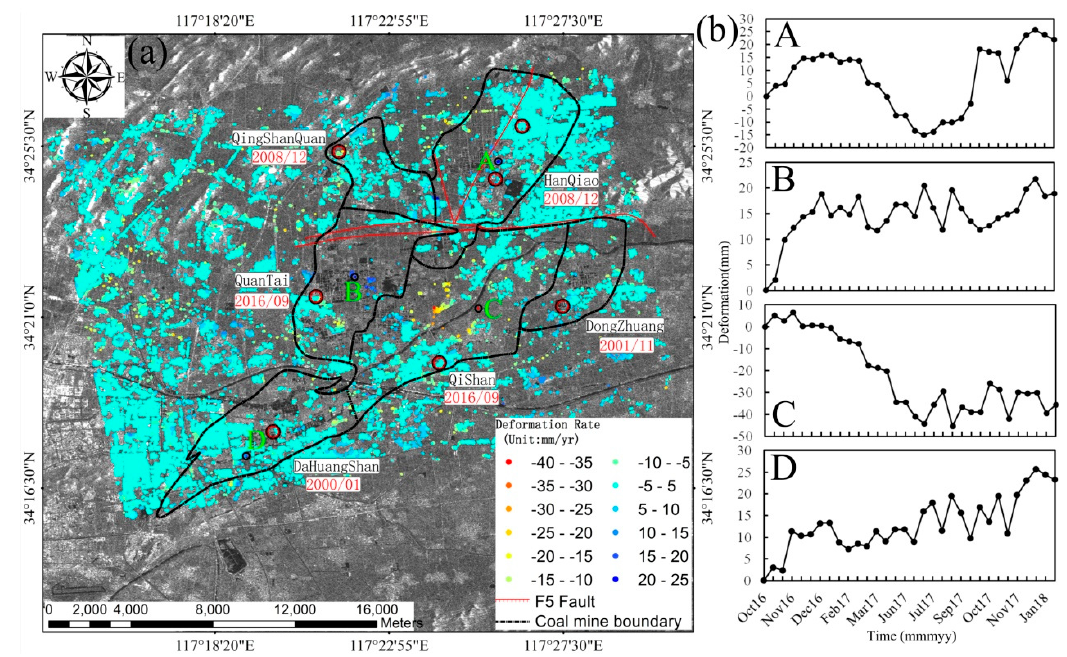
Figure 5. The LOS deformation from October 2016 to January 2018. ( a ) The LOS annual average deformation rate. The red-black circles show the locations of the main wells in the mining area. The black circles show the location of the pixels whose time-series are showed in ( b ), and the base map is the intensity image of ENVISAT obtained on 16 March 2010. ( b ) The LOS time-series deformation.